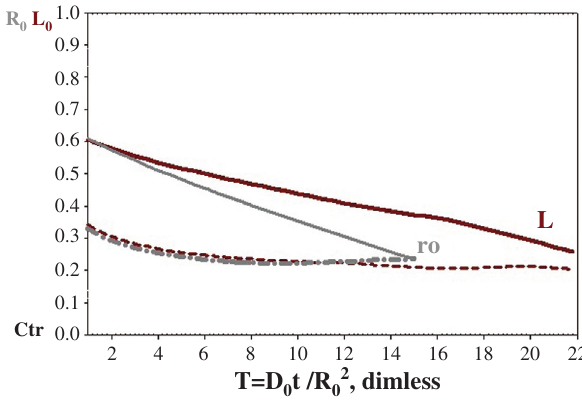
Variant 2. Six (6)-component system (anion Cl - ). General- Figure 7 6 L,ro (T), (solids); ized dependences for integral parameters: CM 6 R L,ro (T), (dashed). Propagation of Disp R 0 wave: L- membrane 6 R 6 ( brown ), ro -fiber (gray). Ordinate axes: distance from matrix bound- = 1) until “zero” point ( L , ro = 0): 1 > L , ro > 0. D = 0.01; , ro ary ( L 0 0 1Cl = 0.01;D = 0.03. K = 0.6; K = 25; K = D 5HCl 4H 1 2 3